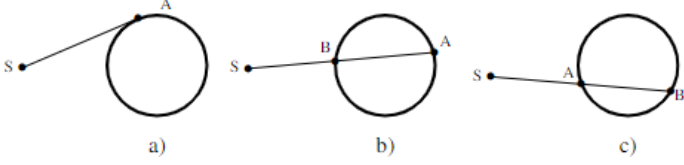
Figure 10. Possibilities for signal blockage due to Earth’s